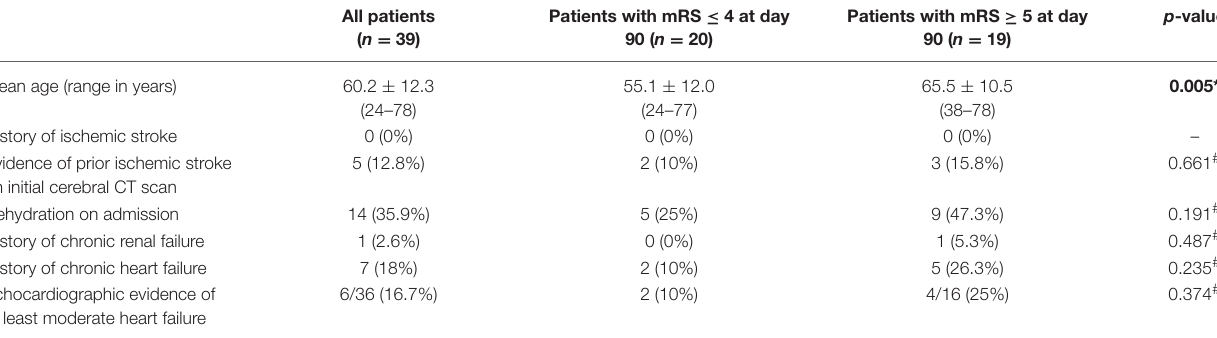
TABLE 1 | Baseline characteristics.